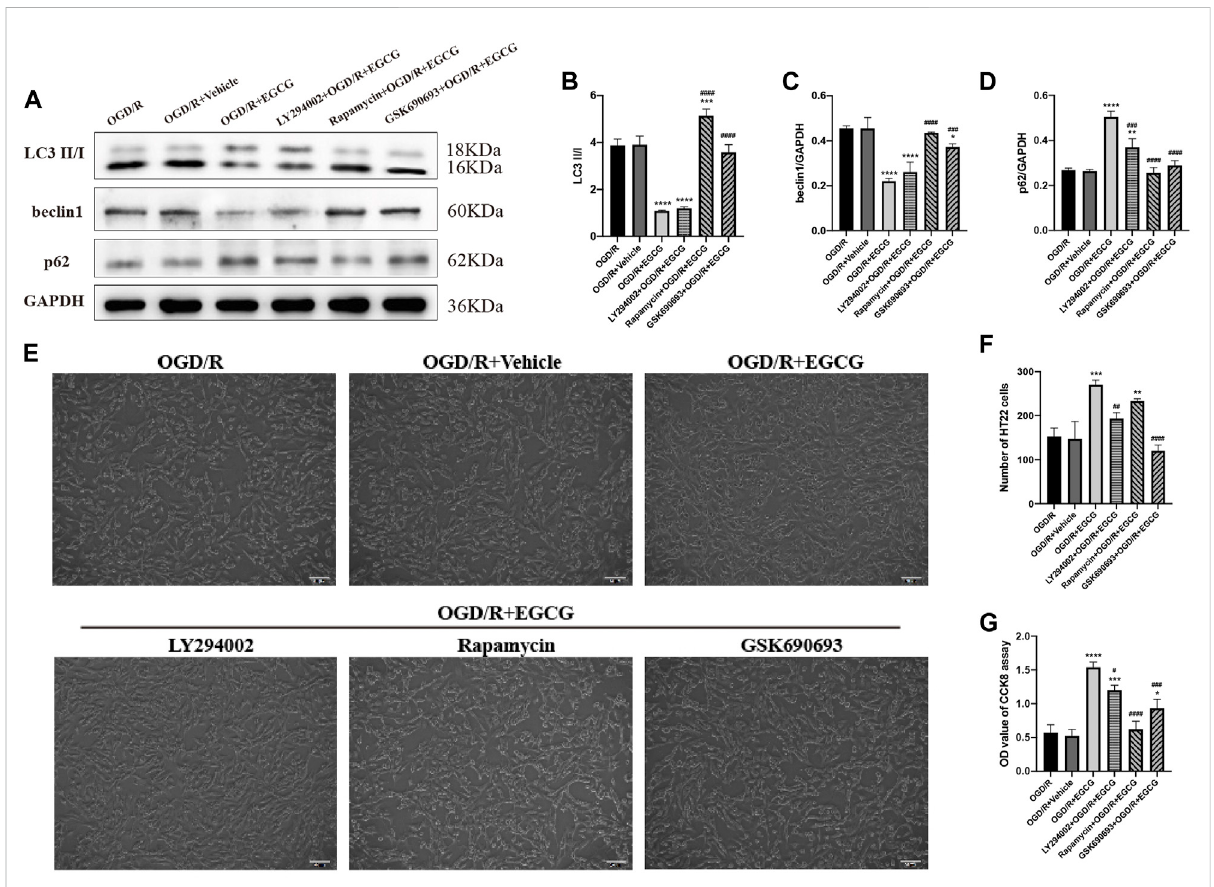
FIGURE 7 LY294002, GSK690693, and rapamycin reversed the effect of EGCG in HT22 cells challenged by oxygen-glucose deprivation/reperfusion (OGD/R). (A) The expressionofLC3 II/I (B) , beclin1 (C) ,and p62 (D) wasassessedbyWesternblotting assay. (E) The number (F) andcell viability (G) of HT22 cells in different groups. Each experimental datum was presented as mean ± standard deviation ( n = 3 per group). * p < 0.05, ** p < 0.01, *** p < 0.001, **** p < 0.0001 versus OGD/R group, # p < 0.05, ## p < 0.01, ### p < 0.001, #### p < 0.0001 versus OGD/R + EGCG